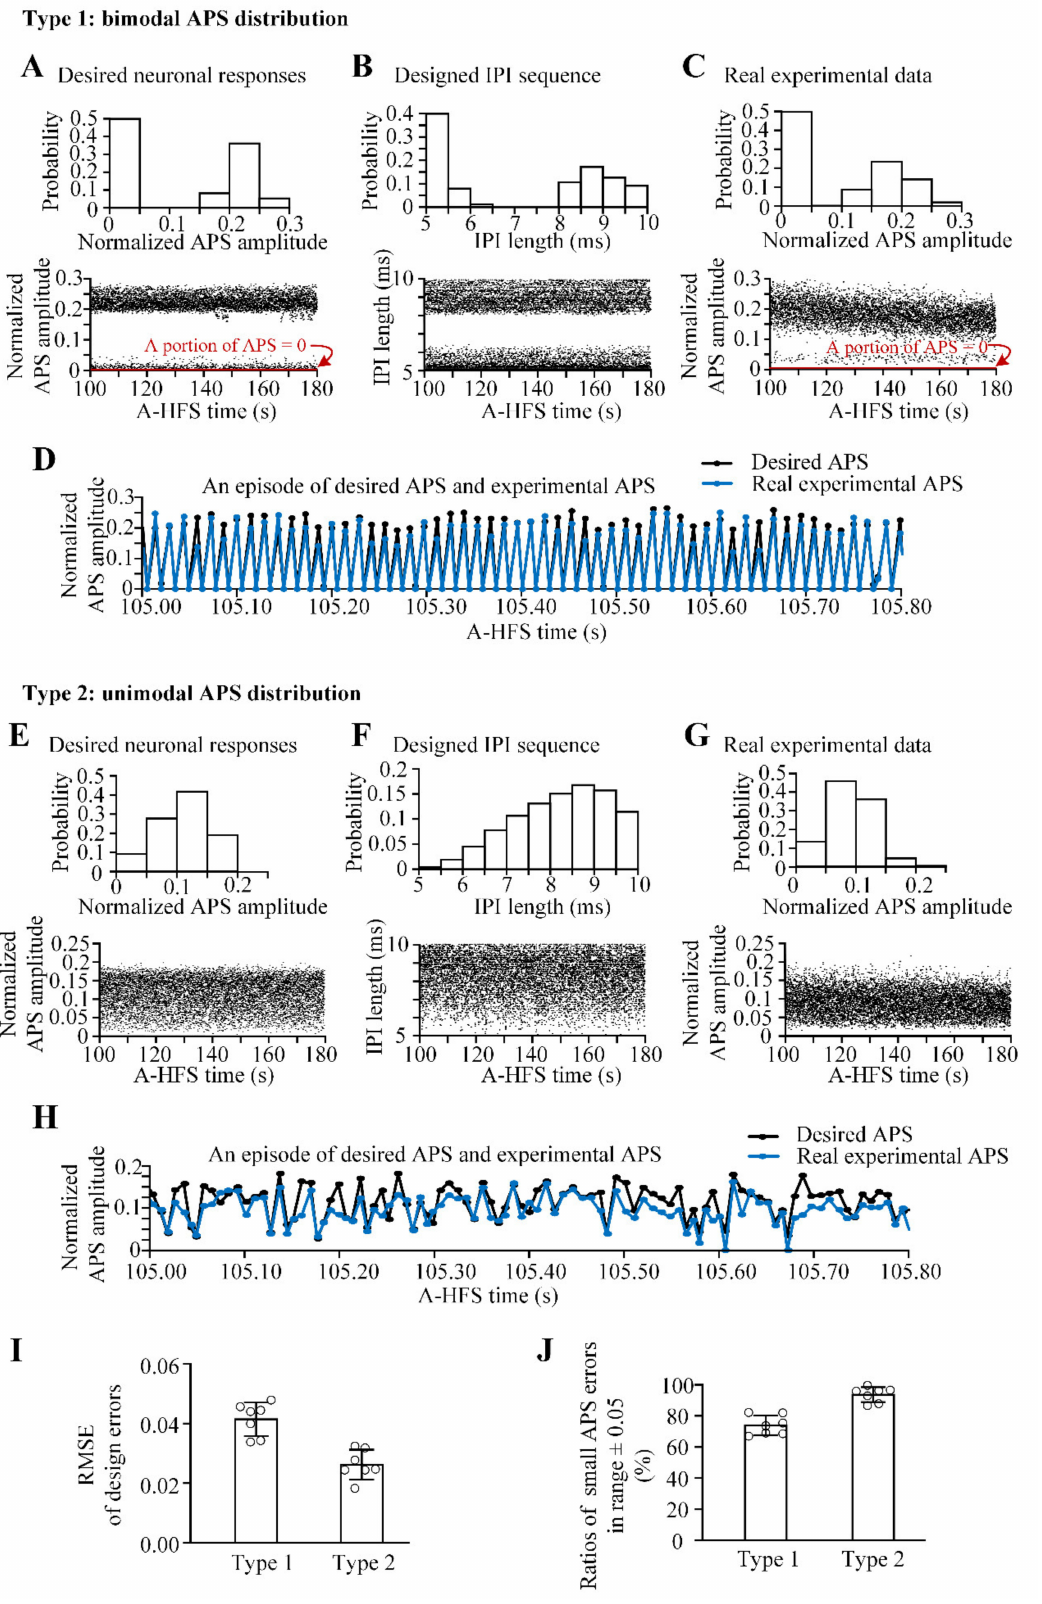
Figure 5. Verification of designed pulse sequences for two different types of desired neuronal responses: Type 1 for a desired APS distribution with bimodal APS amplitudes ( A – D ) and Type 2 for a desired APS distribution with unimodal APS